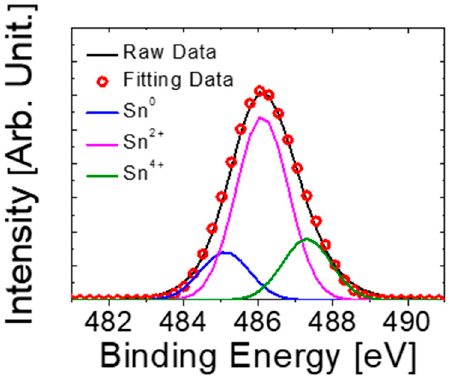
Figure 3. X-ray photoelectron spectroscopy (XPS) Sn 3 d 5/2 spectra of the tin oxide thin-film deposited on the SiO 2 /Si substrate.